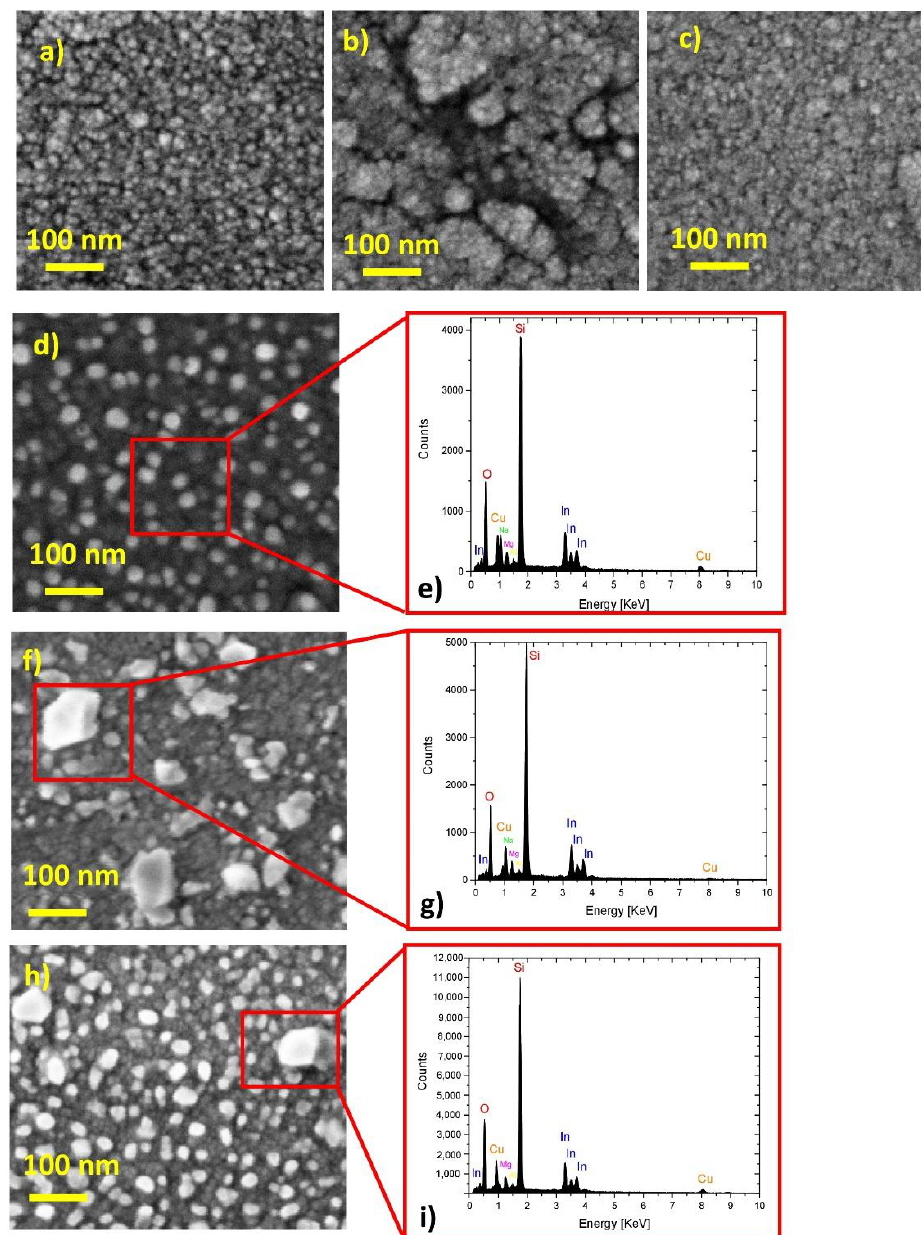
Figure 1. SEM images of ( a ) as-deposited IZrO botttom layer surface; ( b ) the surface of as-deposited Cu on IZrO bottom layer; ( c ) glass substrate/IZrO bottom/Cu stack after a thermal annealing at 200 °C; ( d ) glass substrate/IZrO bottom/Cu stack after a thermal annealing at 300 °C; ( e ) EDX spectrum of the sample shown in ( d ) acquired over the Cu nanostructures on the position indicated by the red square; ( f ) glass substrate/IZrO bottom/Cu stack after a thermal annealing at 400 °C; ( g ) EDX spectrum of the sample shown in ( f ) acquired over the Cu nanostructures on the position indicated by the red square; ( h ) glass substrate/IZrO bottom/Cu stack after a thermal annealing at 500 °C; ( i ) EDX spectrum of the sample shown in ( h ) acquired over the Cu nanostructures on the position indicated by the red square.